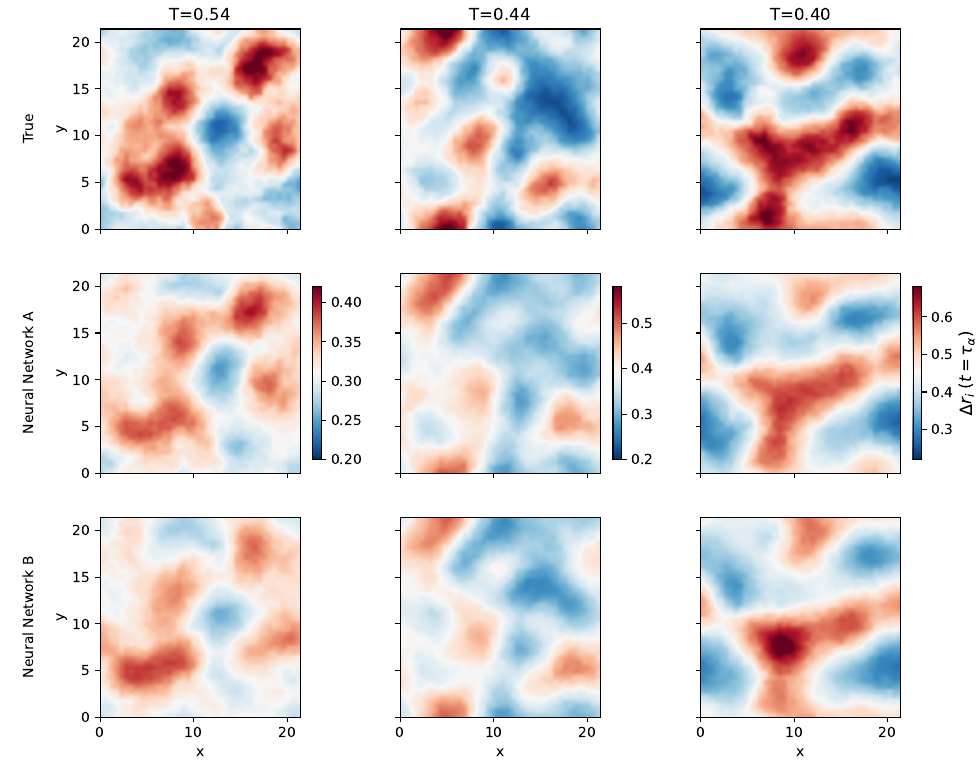
Figure 3. Comparison of the true and the predicted propensity maps of the neural networks A and B for three different temperatures. Both NNs are trained at a given temperature and the predictions inspected at the same temperature. Maps are obtained by interpolating the propensities of particles belonging to a slice of height h = 1 along the z axis of the simulation cubic box. The predicted propensity are obtained with (second row) and without (third row) the local DW in the input data set. Colorbars refer to the entire columns (i.e., the given